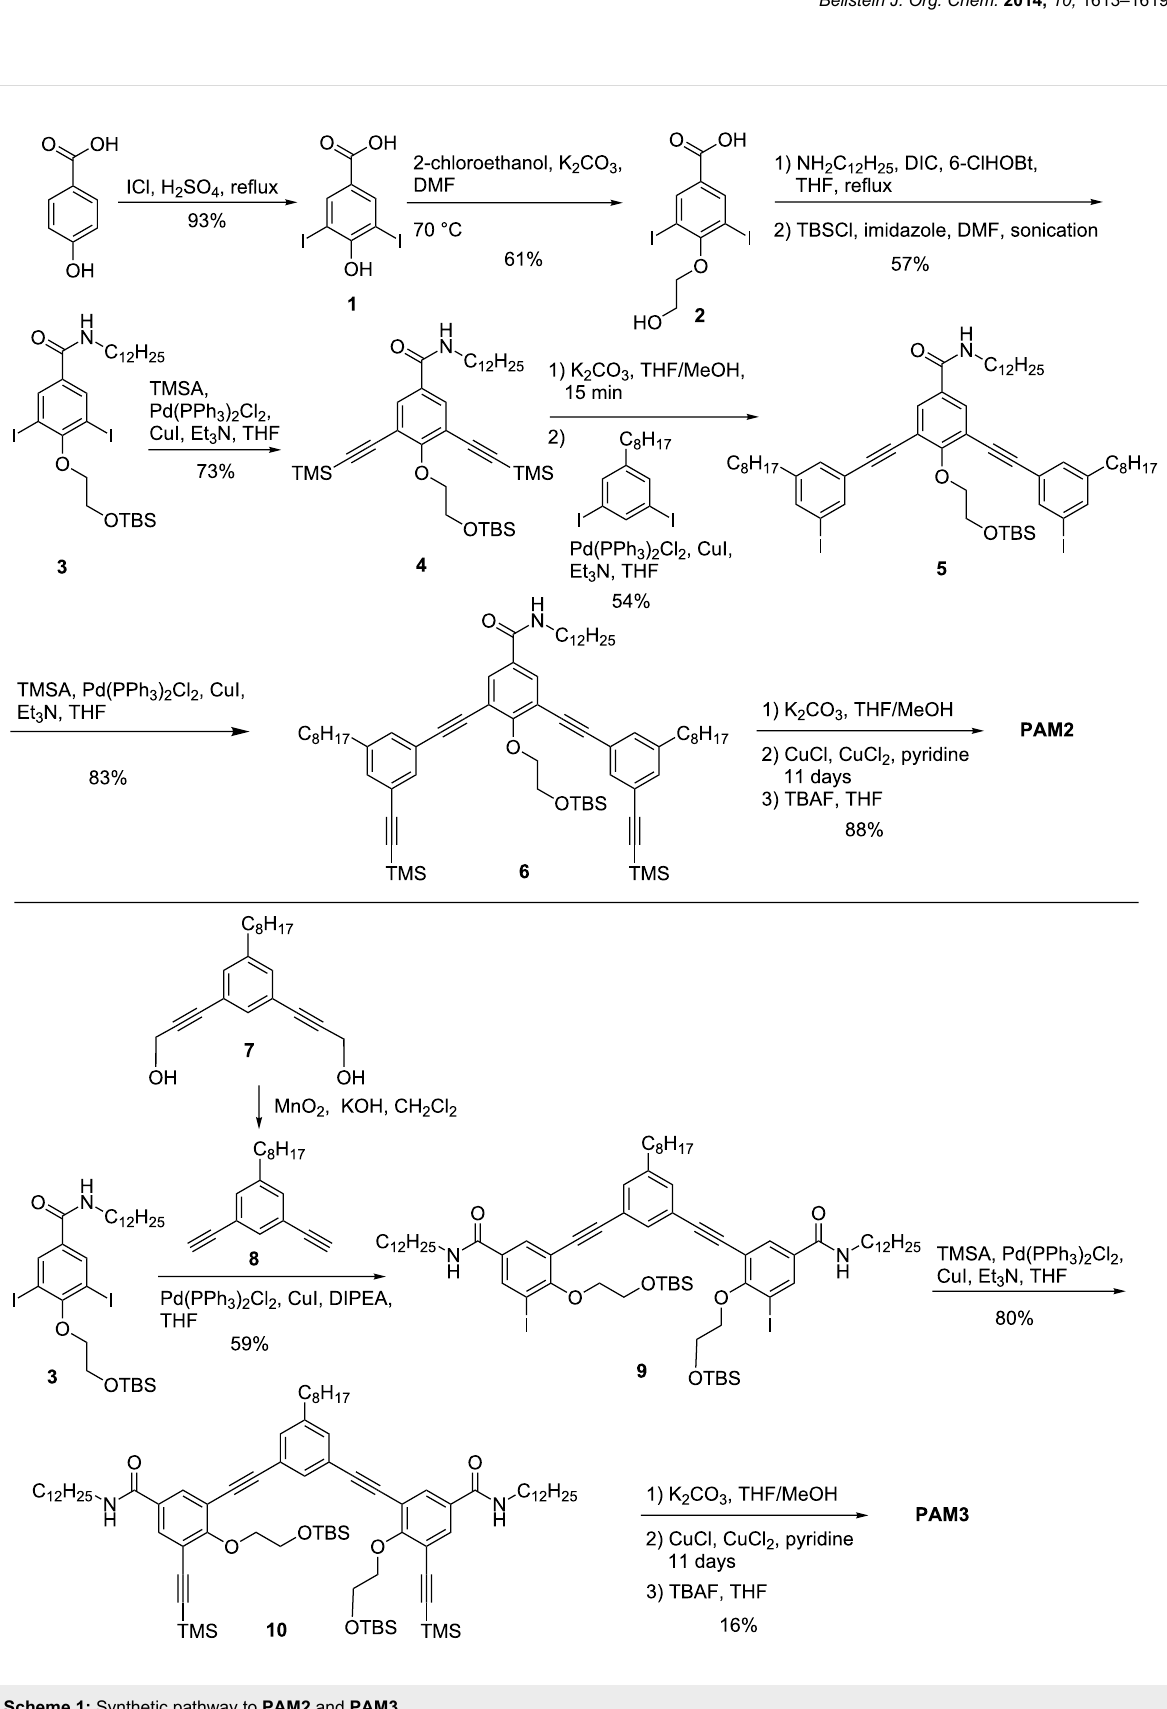
Scheme 1: Synthetic pathway to PAM2 and PAM3